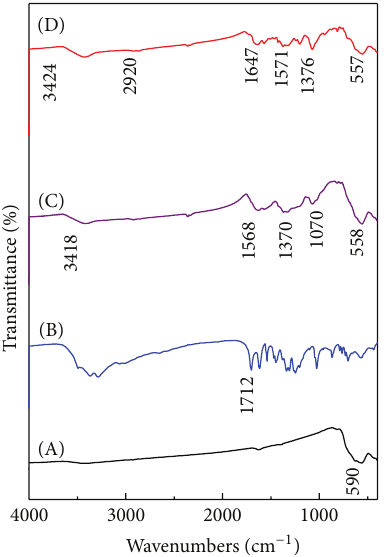
Figure 2: FTIR spectra of FNPs (A), pure GA (B), FPVAG (C), and FPEGG nanocomposite